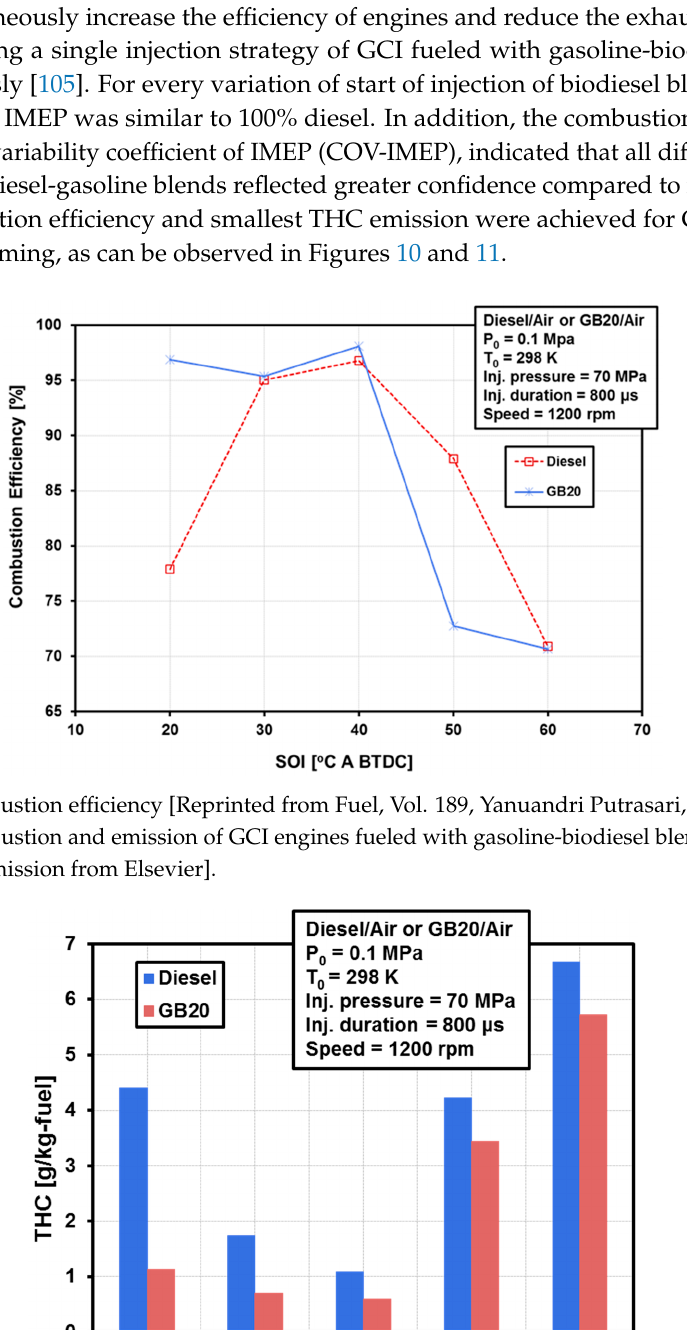
Figure 9. Effect of the biodiesel fraction on auto-ignition [Reproduced with permission from Vu, D.N.; Das, S.K.; Jwa, K.; Lim, O., Proc. Inst. Mech. Eng. Part D J. Authomob. Eng.; published by SAGE